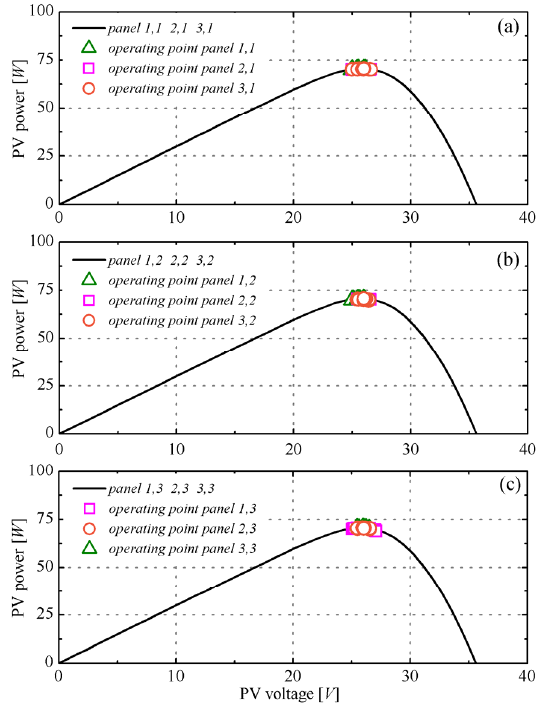
Figure 5. Sunny case: the operating point position corresponding to three panels in the p -th phase leg (namely, panel 1, p (pink squares), panel 2, p (orange circles), and panel 3, p (green triangles)) is highlighted with respect to the individual panel P–V curves (solid line). ( a ) Phase leg 1; ( b ) phase leg 2; ( c ) phase leg 3.